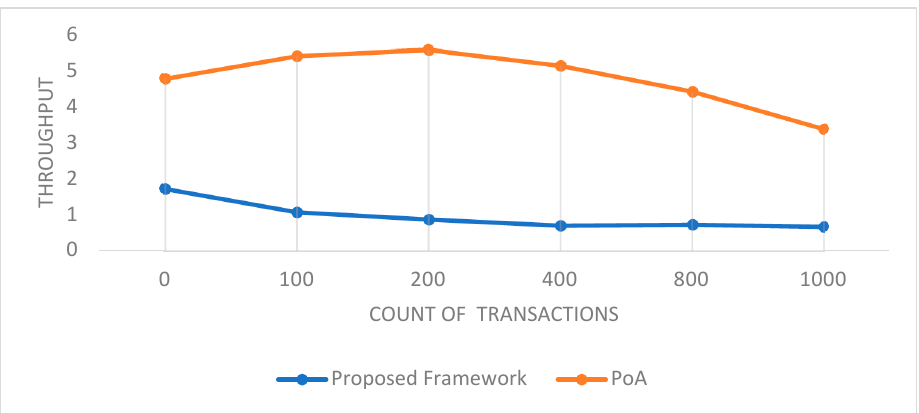
Figure 17. Average throughput of proposed framework compared with PoA.